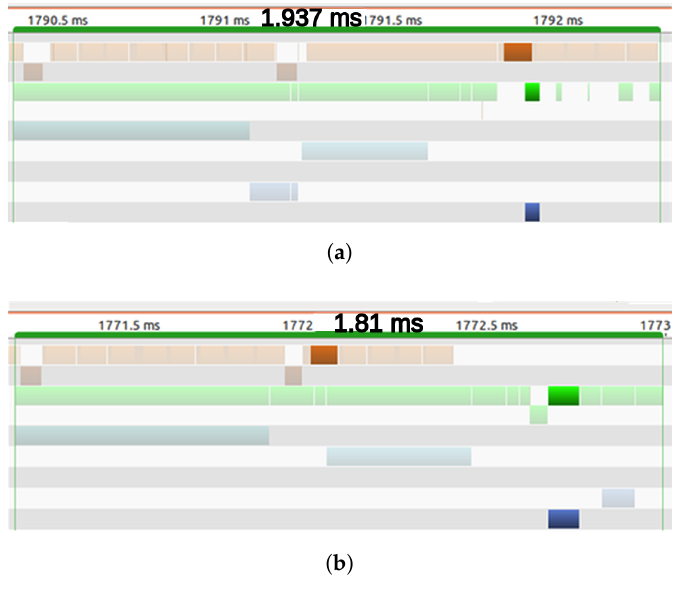
Figure 9. Launch time (orange) and execution time (green) for both strategies: ( a ) performing Motion Detection Filter first and ( b ) launching the maximum number of